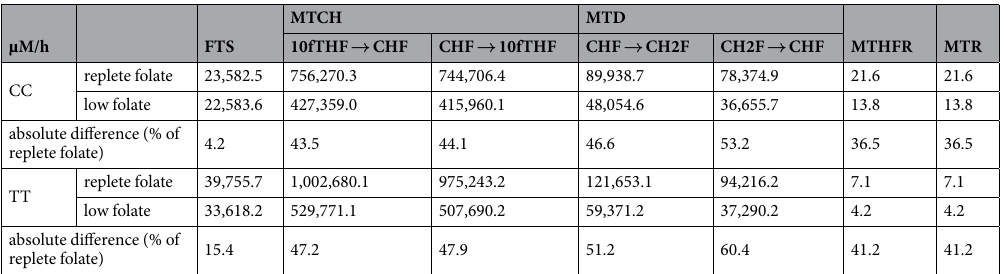
Table 8. Fluxes of the reactions catalyzed by the enzymes FTS, MTCH, MTD, MTHFR and MTR for replete (18 µ M) and low (9 µ M) levels of total folate and for the CC and TT case of the C677T MTHFR polymorphism.